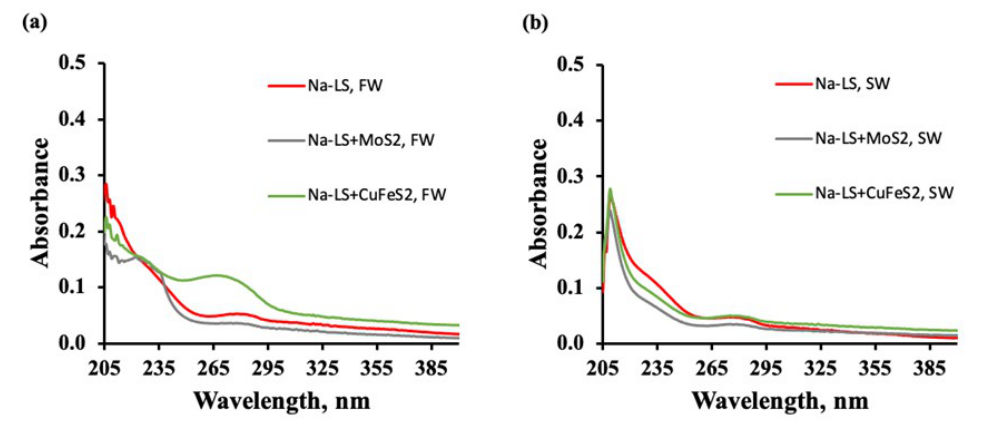
Figure 11. Absorbance spectra of Na-LS (10 ppm) before and after contact with molybdenite and chalcopyrite ( a ) freshwater (0.01M NaCl) ( a , b ) seawater.